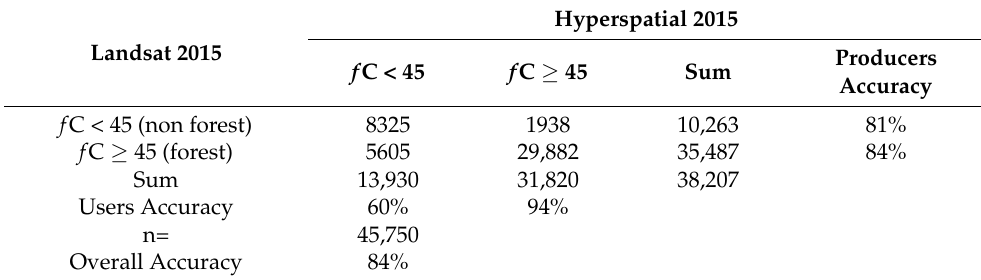
Table A2. The accuracy assessment matrix comparing mapped forest cover from the f C product and measurements from a product that used hyperspatial imagery to map cover at 0.5 m resolution and aggregated to the 30 m grid spatial resolution. (data are shown as number of pixel